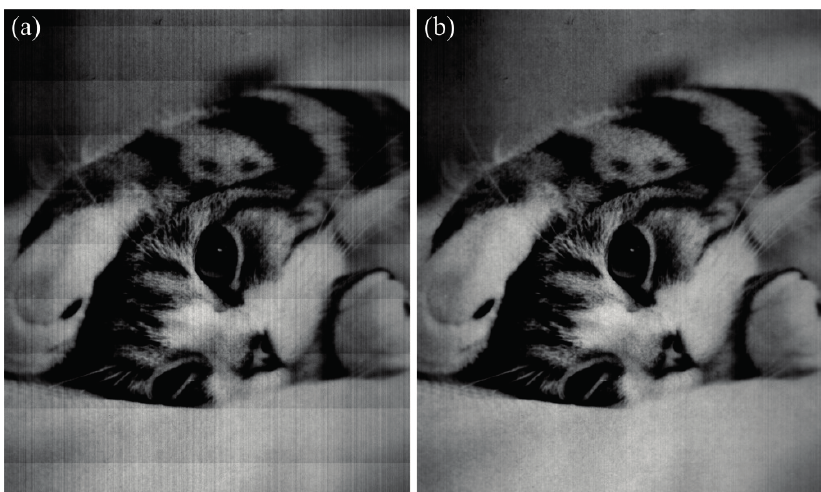
Figure 14. Comparison of visual effect of a real-test image. ( a ) Original image; ( b ) Corrected image.